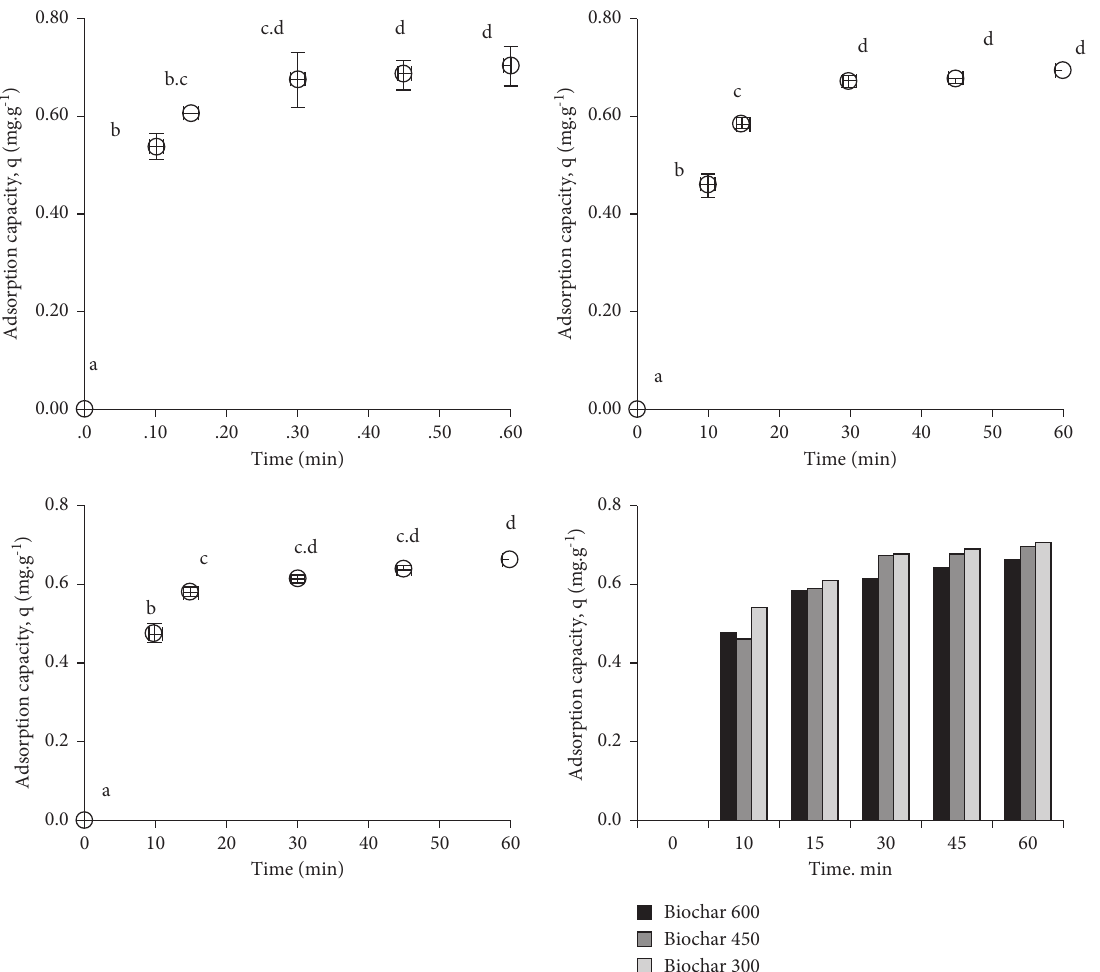
Table 4: Correlations between some properties of biochar and maximum NH +